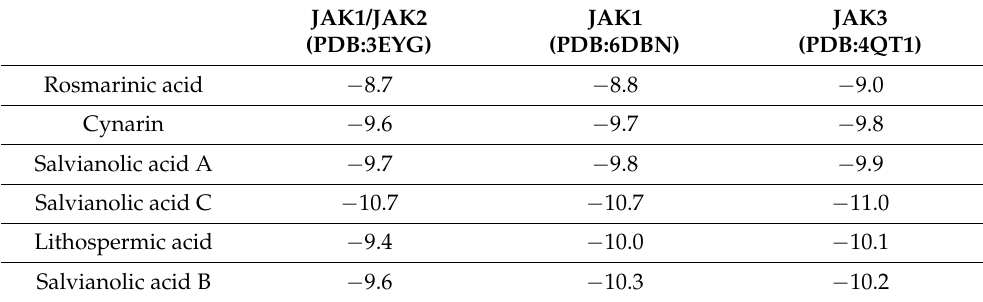
Table 1. JAKs’ binding affinity of six phenolic acids (unit: -kcal/mol).